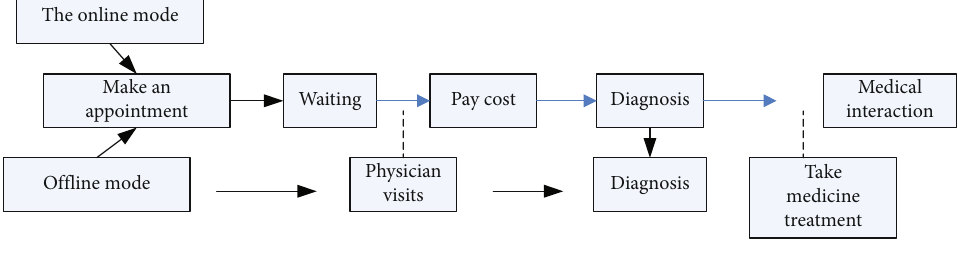
Figure 1: Smart healthcare service model.